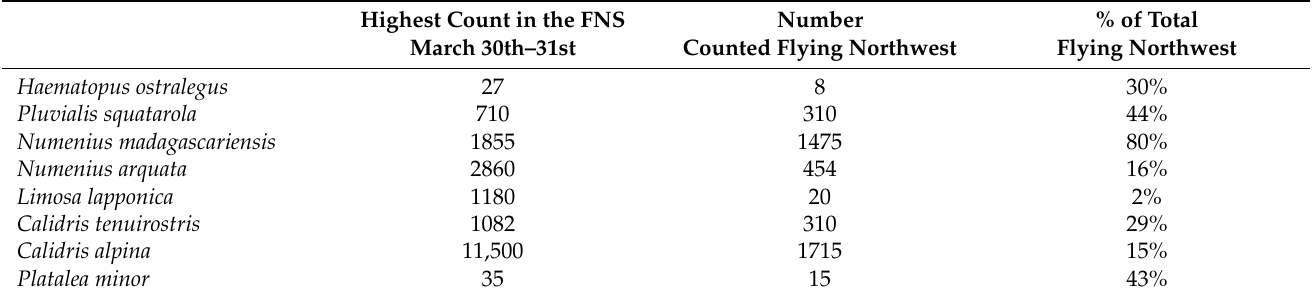
Table 5. Direction of flight of selected shorebird species and of Platalea minor from the Hwaseong Reclamation Lake roost within two hours of a 9.42 m high tide on 31 March 2021. Highest Count in the